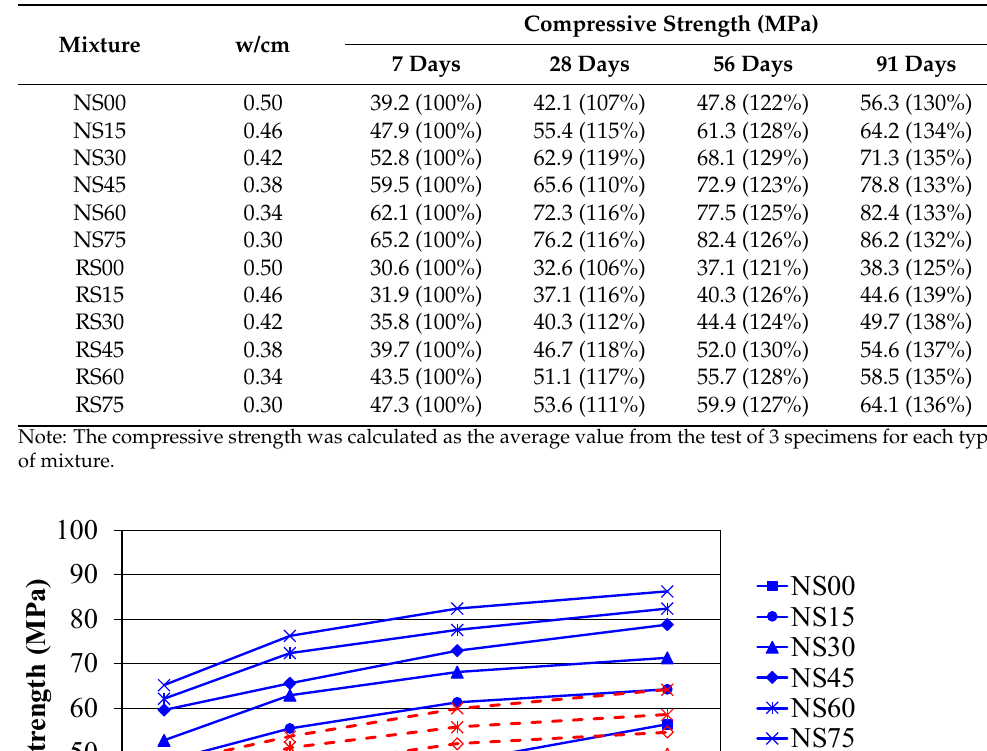
Table 4. Compressive strengths of concretes (MPa).